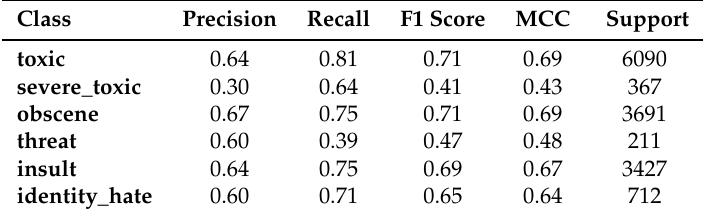
Table 18. Results of the individual toxicity classes of optimized and fine-tuned bare BERT uncased model.